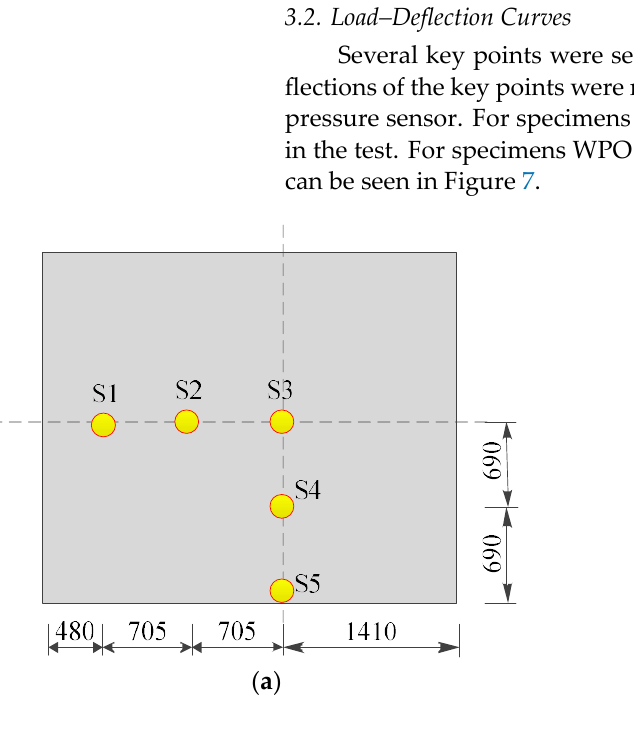
Figure 7. Selected deflection points. ( a ) Deflection points of specimens WP and WN. ( b ) Deflection points of specimens WPO and WNO.